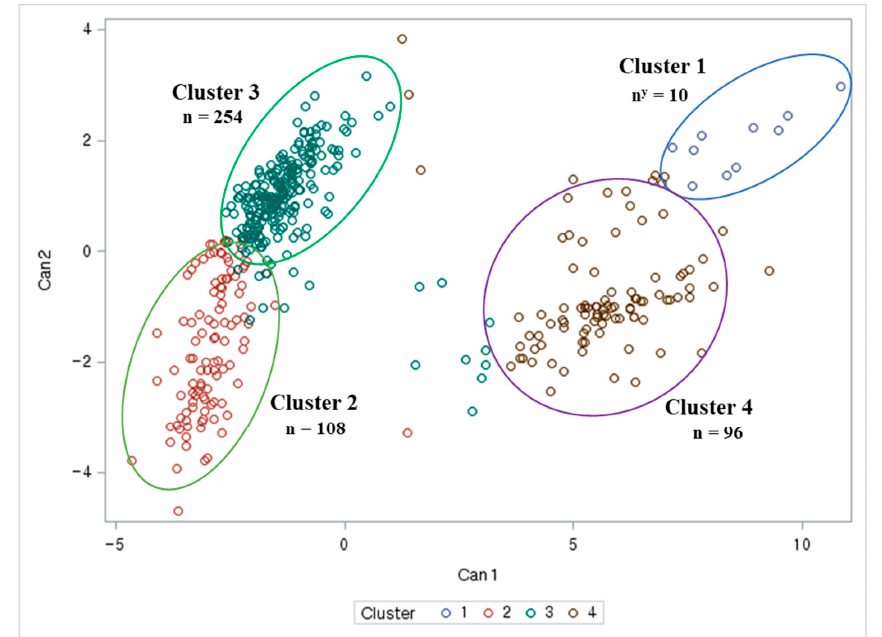
Figure 3. The 4 clusters based on 5 principal components of 468 black soybean germplasms with green cotyledons, including check cultivars ‘Cheongja 3 ′ and ‘Cheongja’. Can: canonical variables; n: number of resources in each cluster.